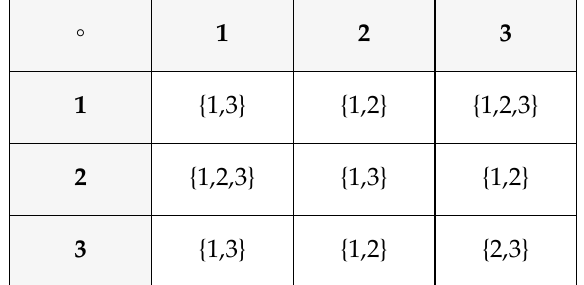
Table 10. Join right almost-hypergroup.